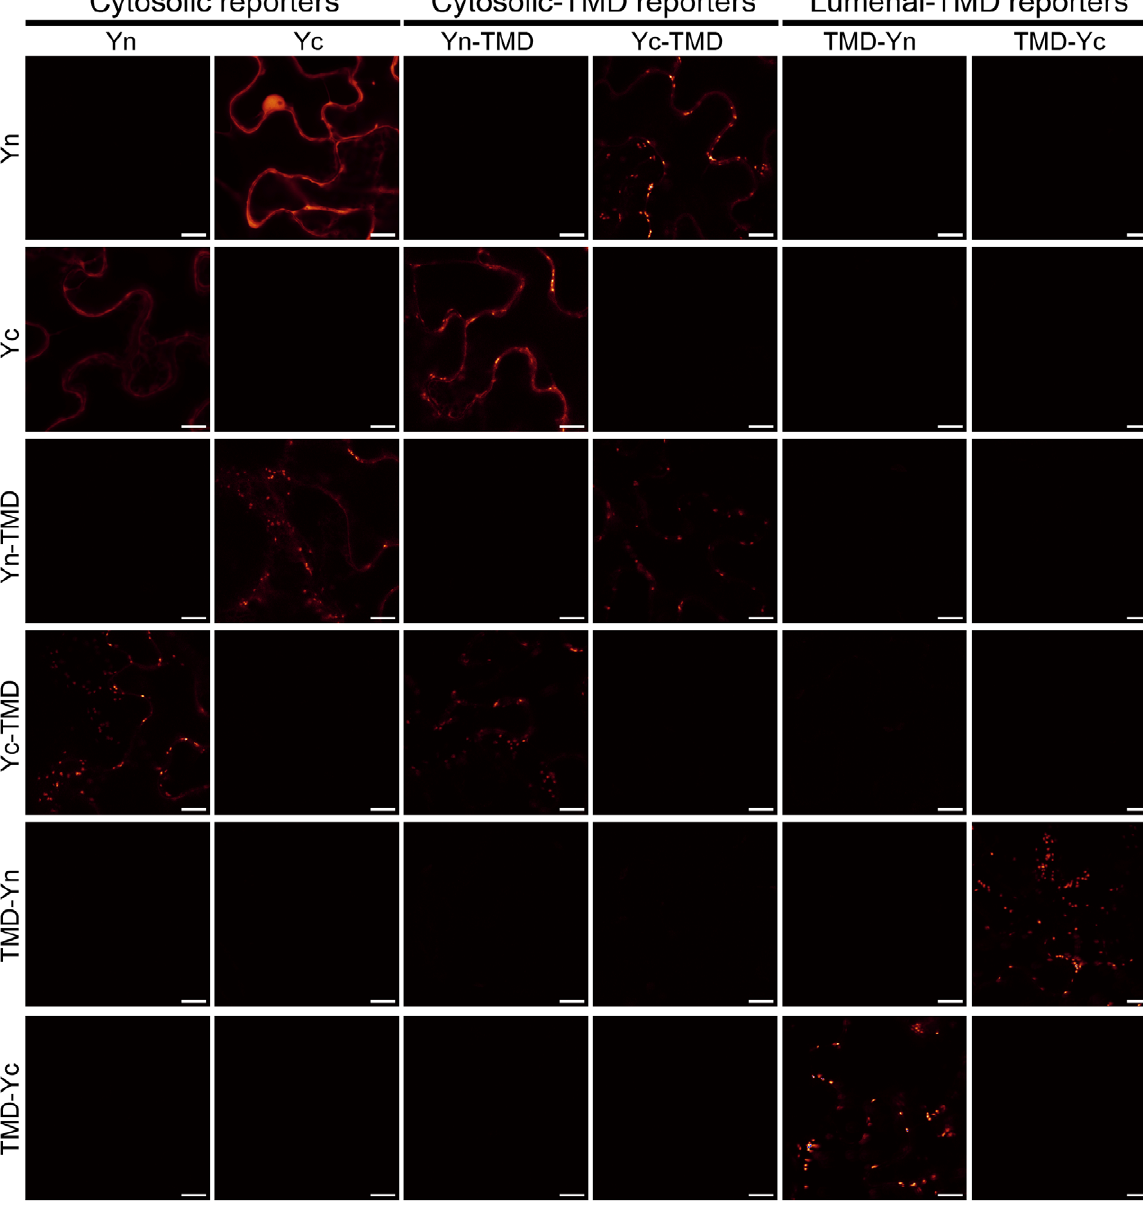
Figure 2. Fluorescence complementation among the GO-PROMTO reporters expressed in the whole leaf tissue of Nicotiana benthamiana at 3 days DPI. The GO-PROMTO reporters were co-expressed and fluorescence complementation was examined by CLSM upon excitation at 514 nm and detection between 529 nm and 599 nm. All scale bars indicate 10 m m. At least two individual experiments were performed for each combination with the similar results. Raw images are shown.